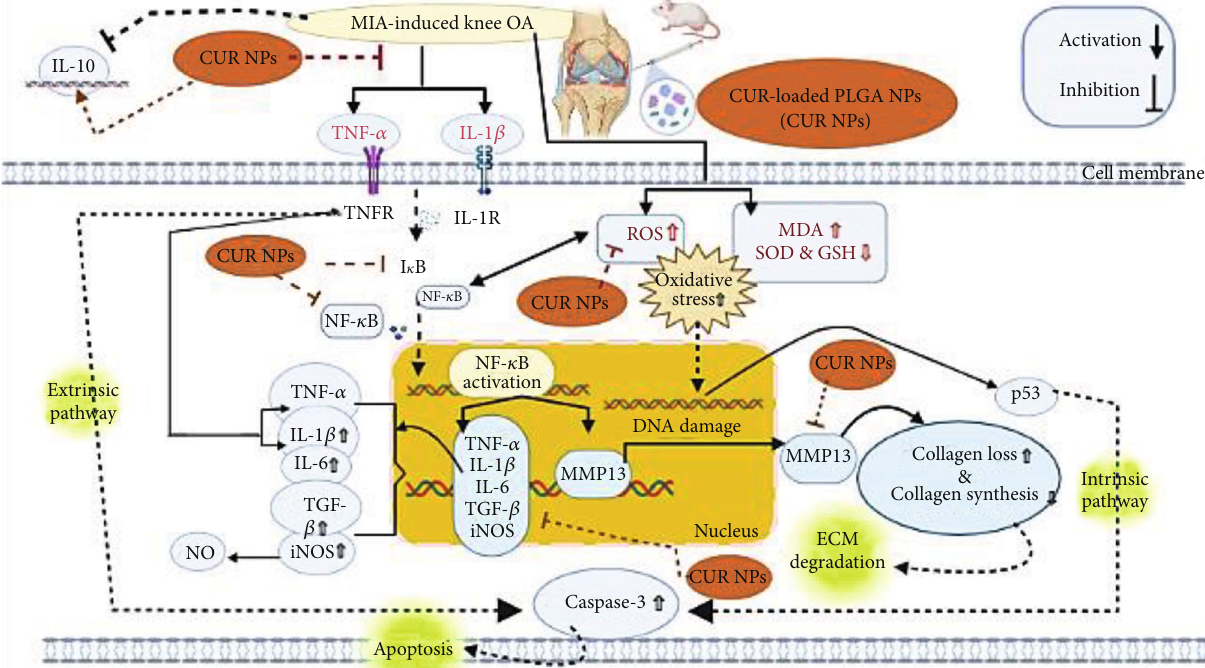
Figure 11: Therapeutic e ff ect of CUR-loaded PLGA NPs against cartilage damage due to in fl ammation, extracellular matrix (ECM) degradation, and apoptosis in MIA-induced knee